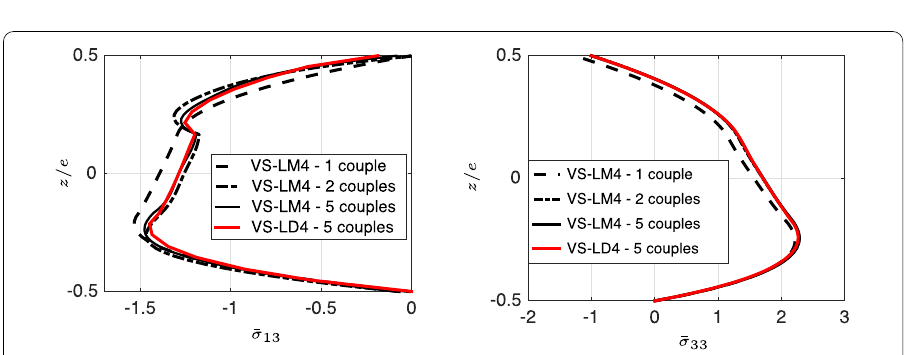
Fig. 9 Distribution of ¯ w (left), ¯ σ 13 (middle), ¯ σ 33 (right) along the thickness—S=4—sandwich B2— φ = π/ 3